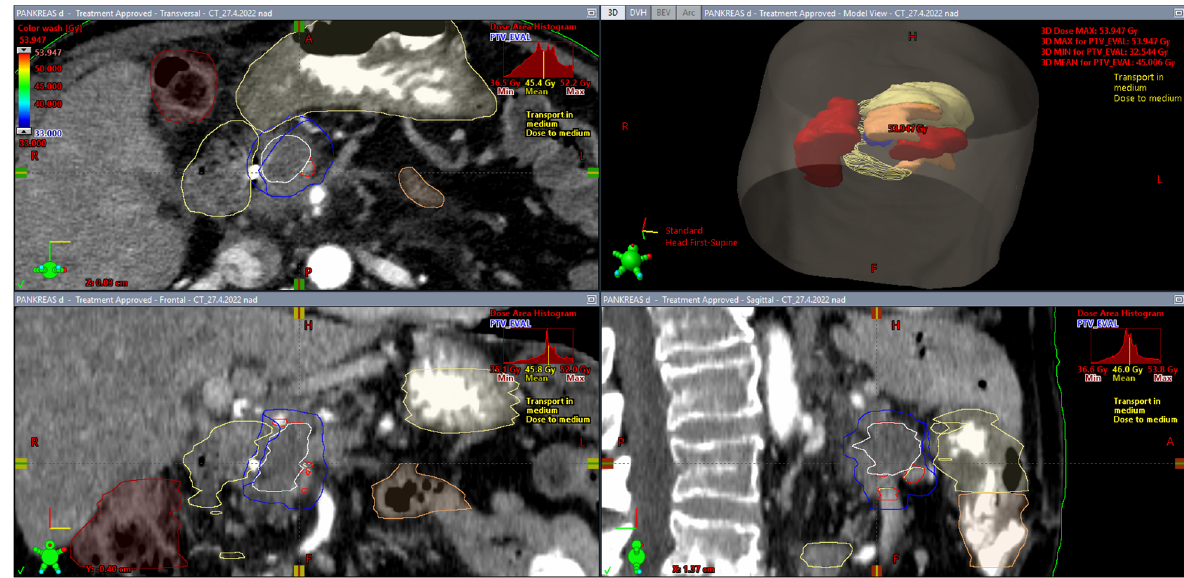
Figure 2. Planning volumes and risk structures. The tumor (GTV, white) and nearby vessels (TVI, red) are contoured. The sum of GTV and TVI forms CTV. A 5 mm expansion of the CTV makes planning target volume (PTV, blue). The main OARs are the duodenum (yellow), stomach (yellow), small bowel (light brown), and large bowel (dark brown). The evaluable PTV (PTV_EVAL, smaller blue volume) is PTV less GI structures with 3–5 mm margins. The fiducial marker is shown at the border of the GTV.